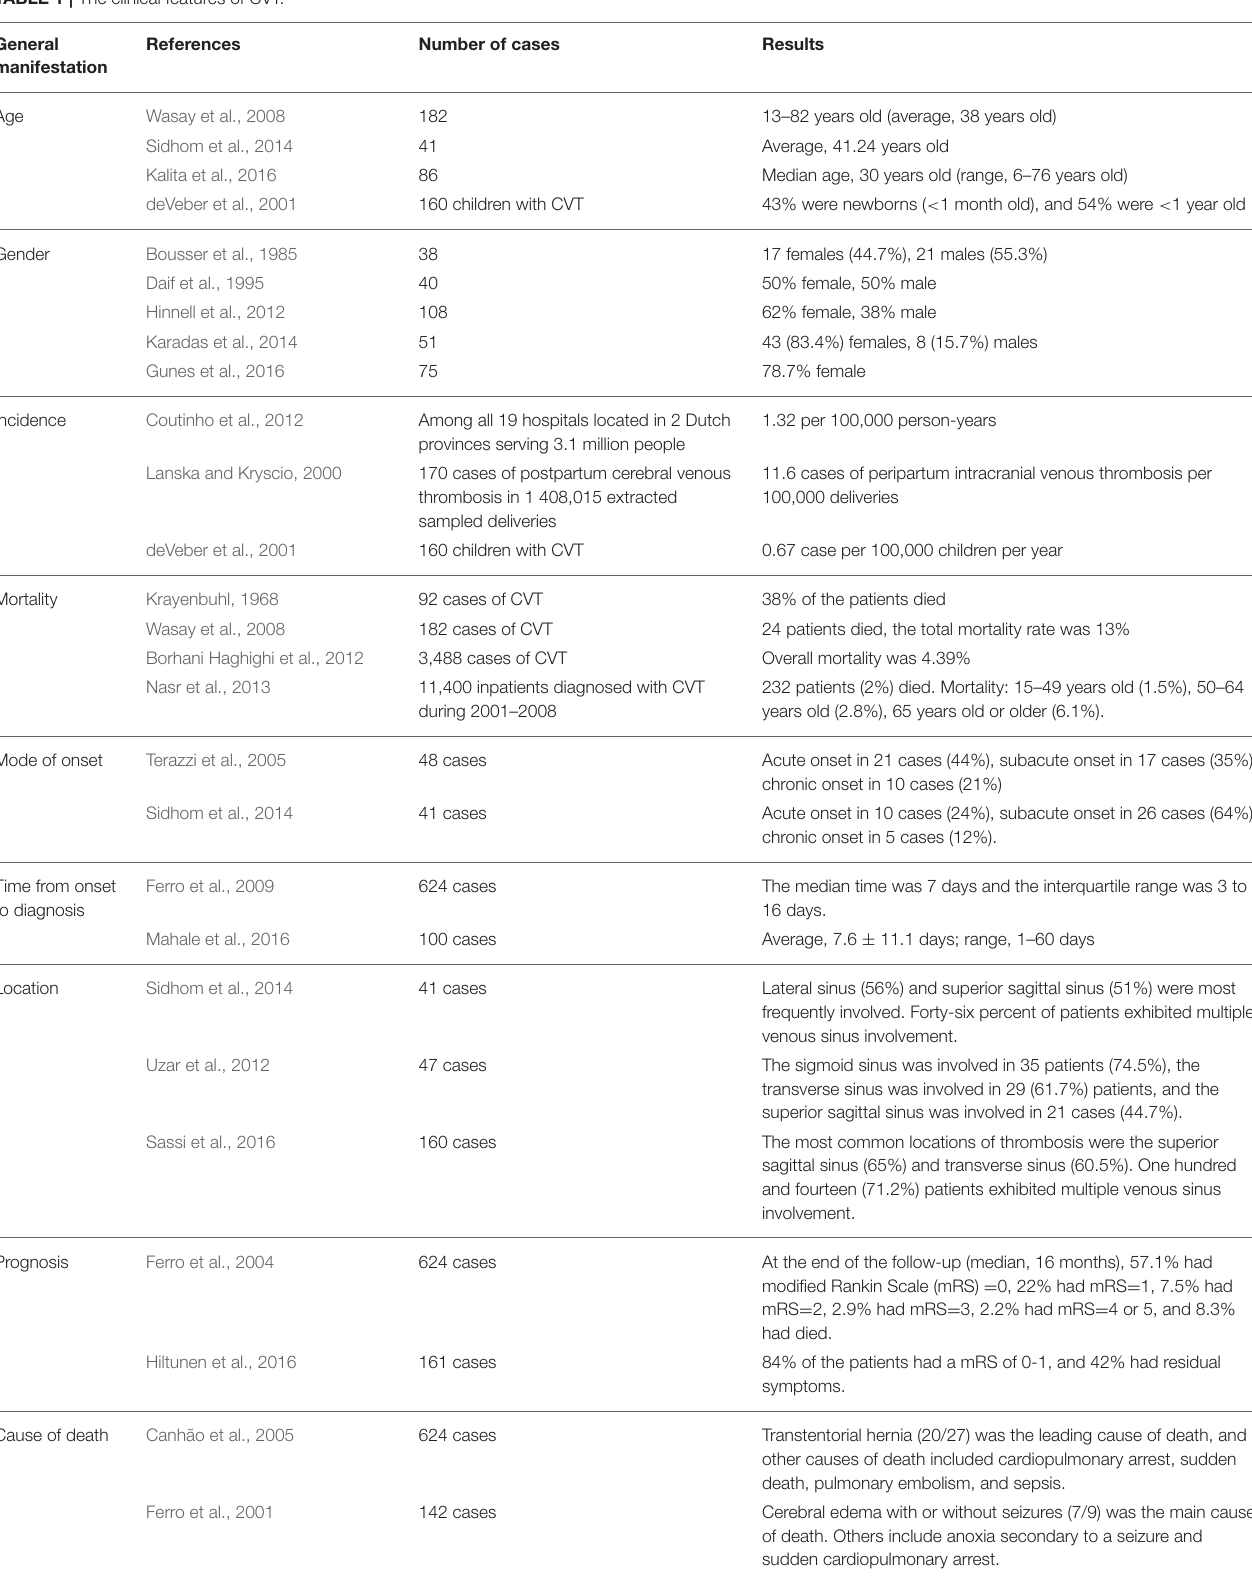
TABLE 1 | The clinical features of